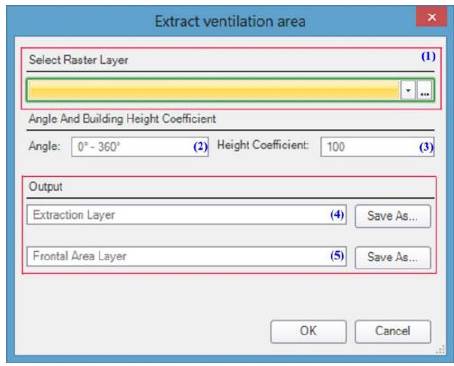
Figure 3. Spatial distribution of SVF at 30 spatial resolution. (a): 1985; (b): 1990; (c): 1995; (d): 2000; (e): 2005; (f): 2010